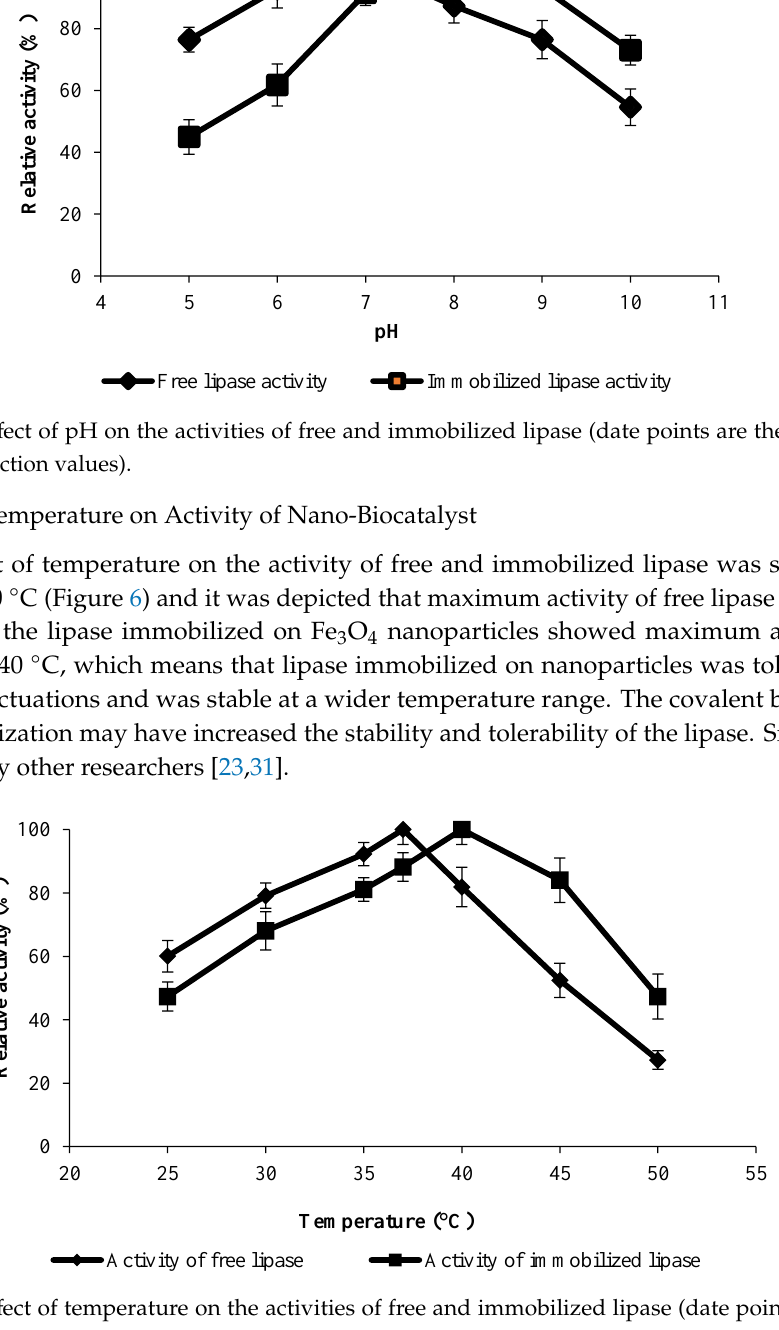
Figure 6. E ff ect of temperature on the activities of free and immobilized lipase (date points are the mean of triplicate reaction values).